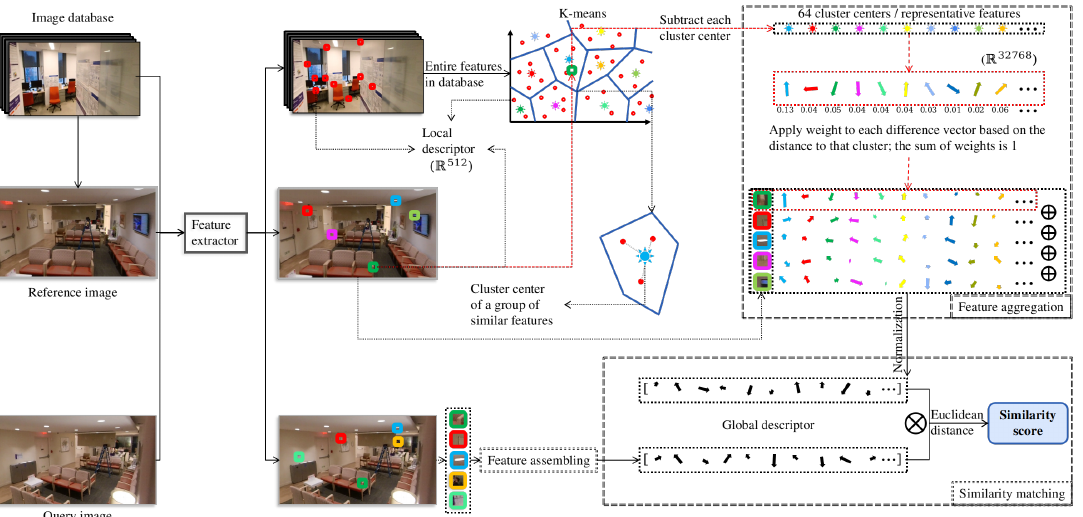
Figure 3. Retrieval-based localization. This diagram demonstrates the steps of feature aggregation and similarity matching using NetVLAD. A pretrained NetVLAD extracts several local descriptors of the query image and each reference image, assembling them into global descriptors and calculating the Euclidean distance between the query image’s global descriptor and that of each reference image; the smaller the Euclidean distance is, the more similar the images